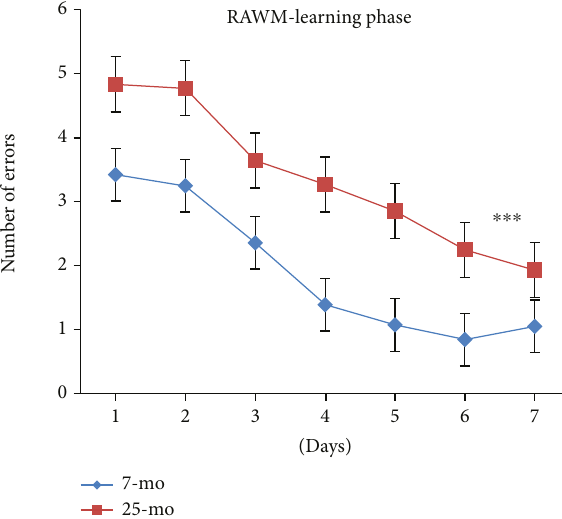
Figure 3: Latencies of 7- and 25-month-old C57BL/6 male and female mice in cued learning of MWM (s, mean ± SEM).